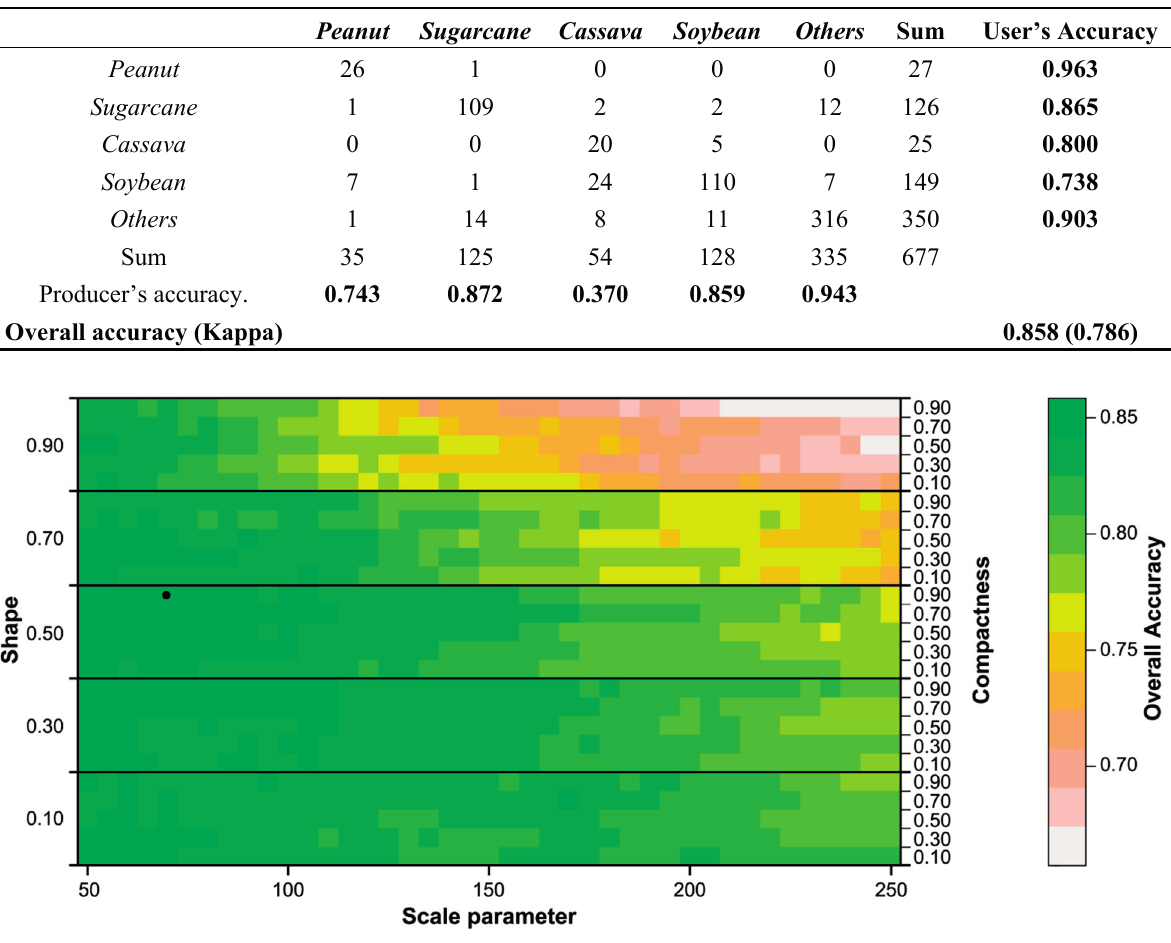
Table 7. Confusion matrix (OOB) of best classification amongst 1025 segmentations and subsequent RF optimizations (incl. feature selection). The best OOB result was obtained for scale = 70, shape = 50 and compactness = 90. The values in the matrix refer to point samples combining samples A and B.